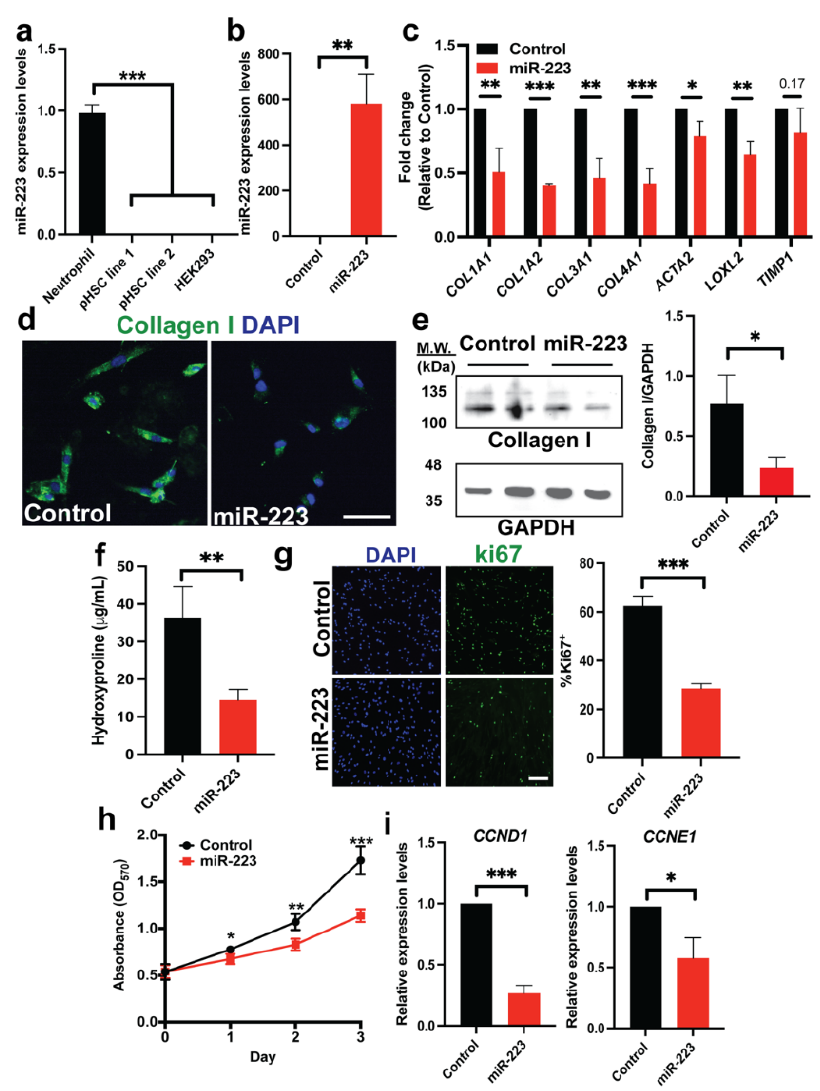
Figure 1. miR-223 suppresses expression of fibrotic markers and proliferation in human HSCs. ( a ) Real-time quantitative PCR (RT-qPCR) of miR-223 expression in human neutrophils (HL-60; positive control), two independent lines of primary human HSCs (pHSCs), and HEK293T